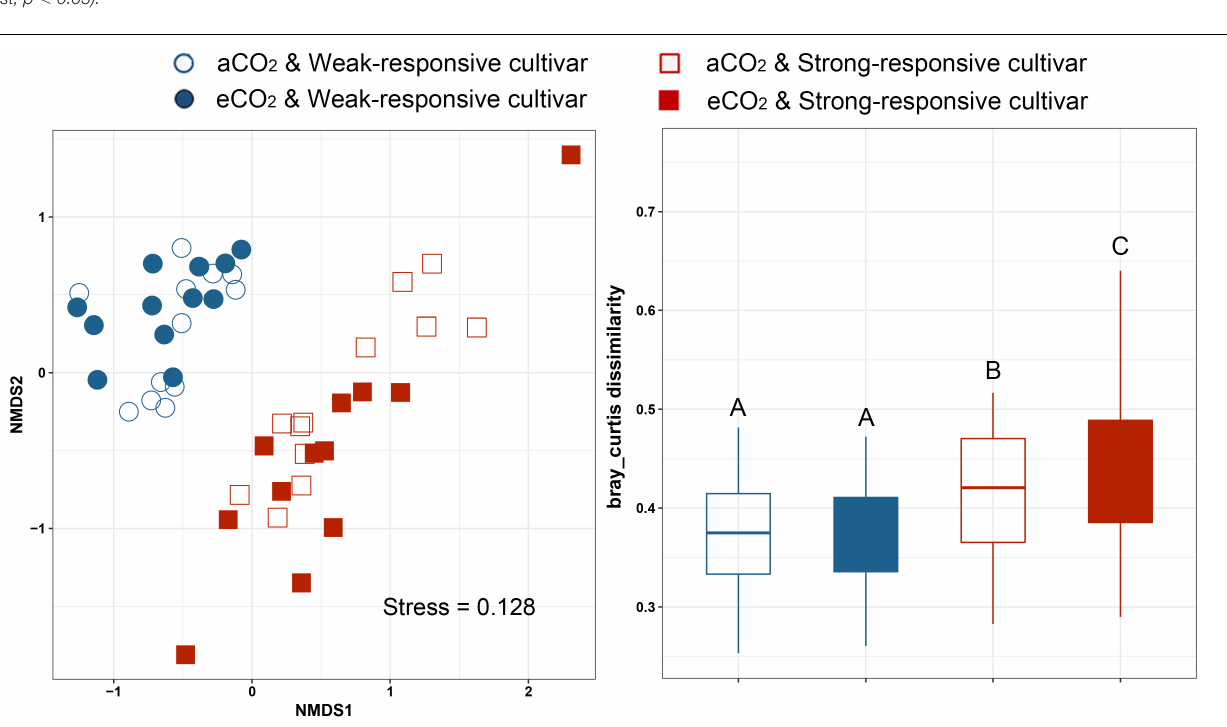
were calculated and compared among different